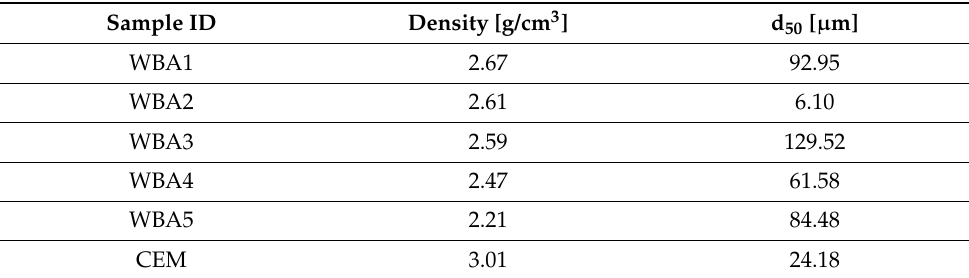
Figure 2. Particle size distribution of WBA and cement samples. Table 6. Physical properties of WBAs and cement.